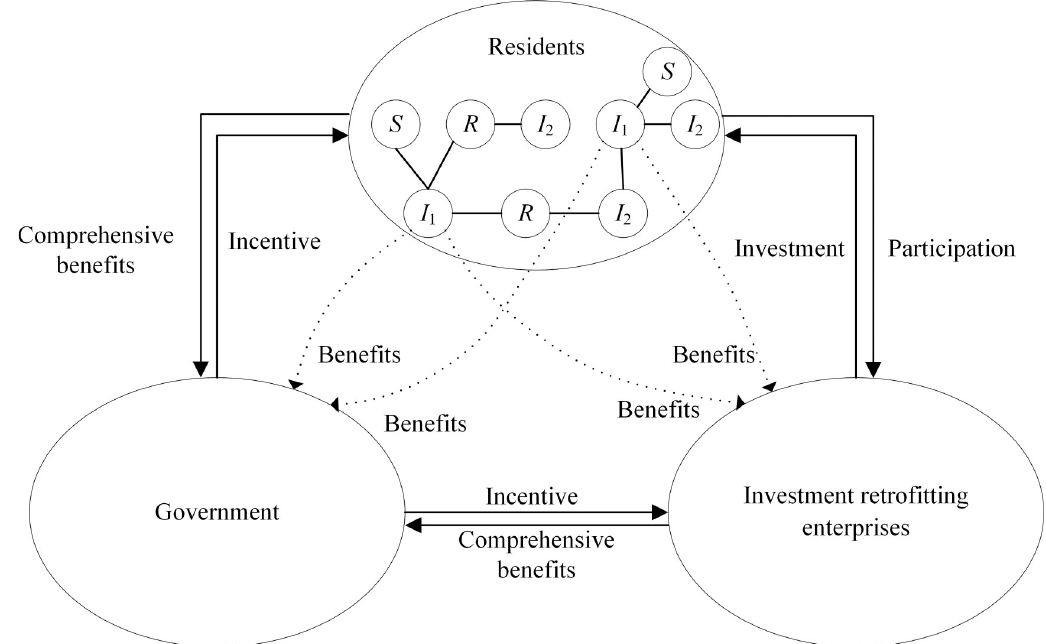
Fig 1. A framework for understanding players’